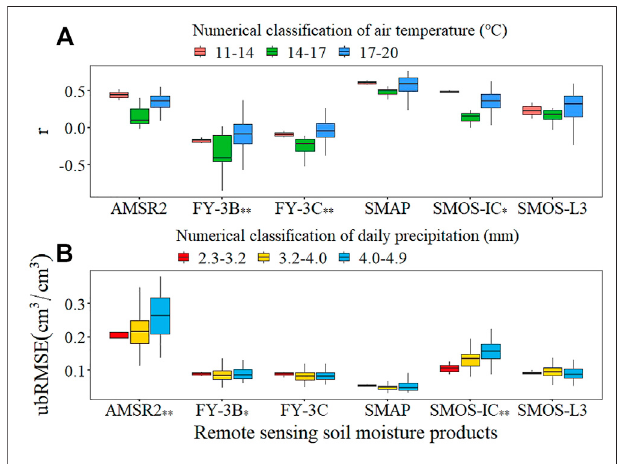
FIGURE 7 | Box diagrams of meteorological factors and error coef fi cients of each product. * indicates the signi fi cance t -test ’ s p < .05 and ** indicates p <